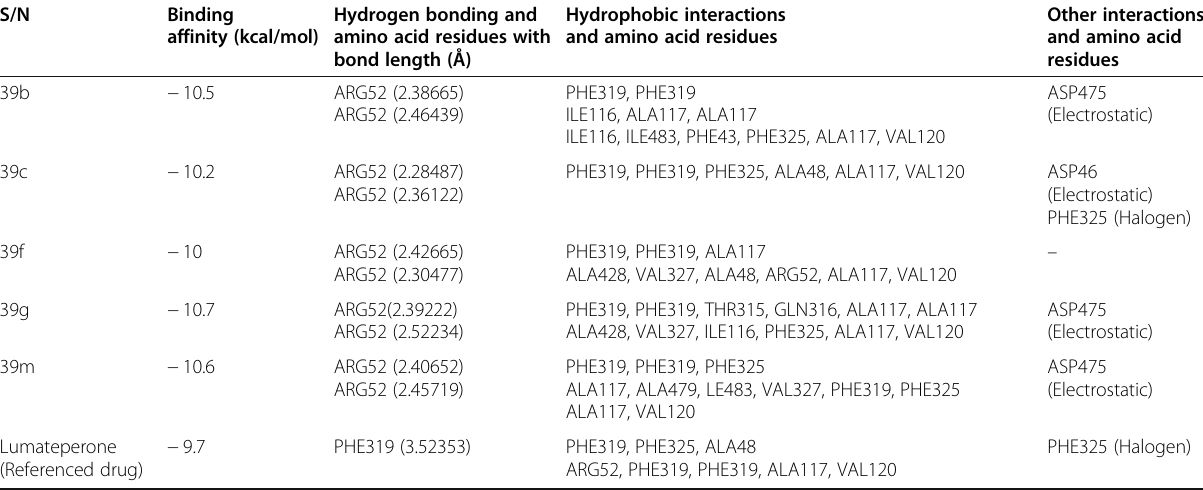
Table 1 Types of interactions and amino acid residues between the target protein and some designed inhibitors S/N Binding Hydrogen bonding and Hydrophobic interactions affinity (kcal/mol) amino acid residues with and amino acid residues bond length (Å)